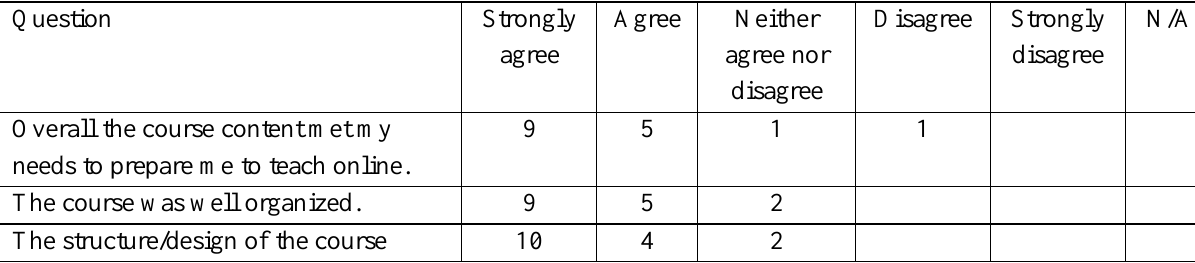
Strongly Agree Neither agree agree nor disagree